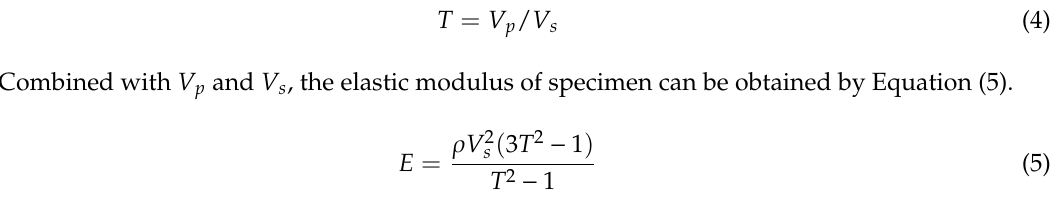
Table 2. Theacoustic parameters of hydrate-bearing sediments formed with natural recovered cores.